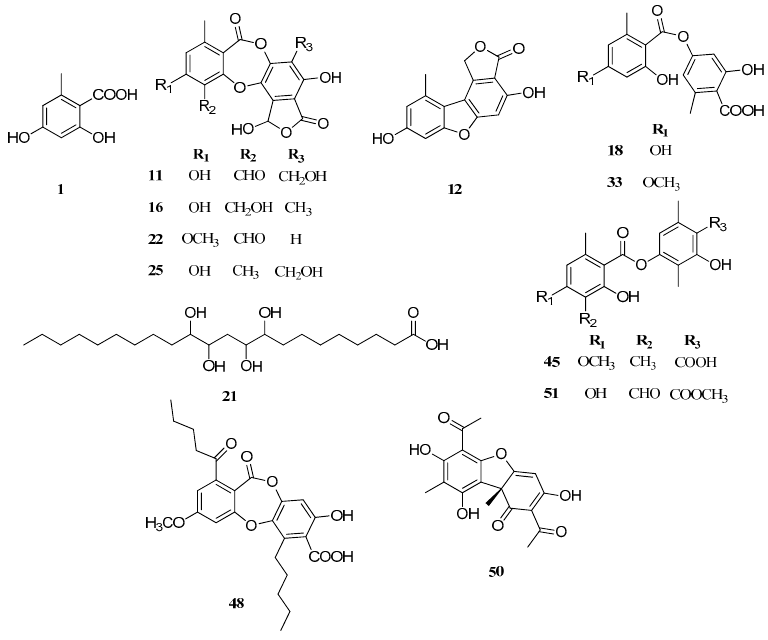
Figure 3. Chemical structures of similar compounds in P. andinum and P. robustum .